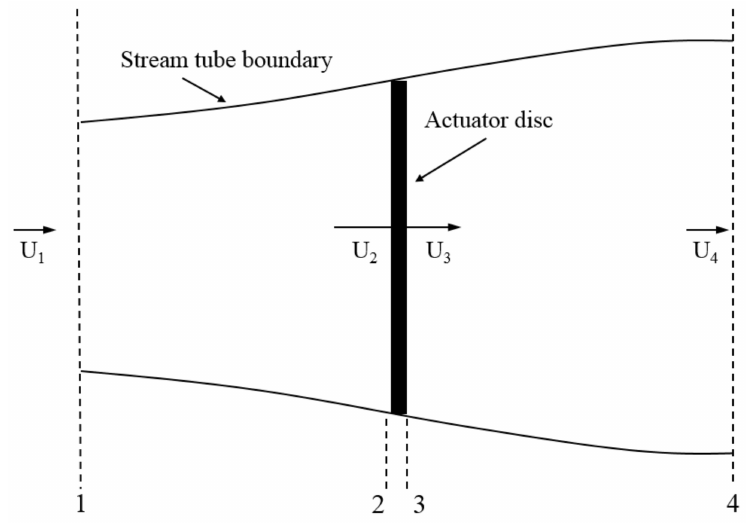
Figure 1. An actuator disc model applied on a tidal current